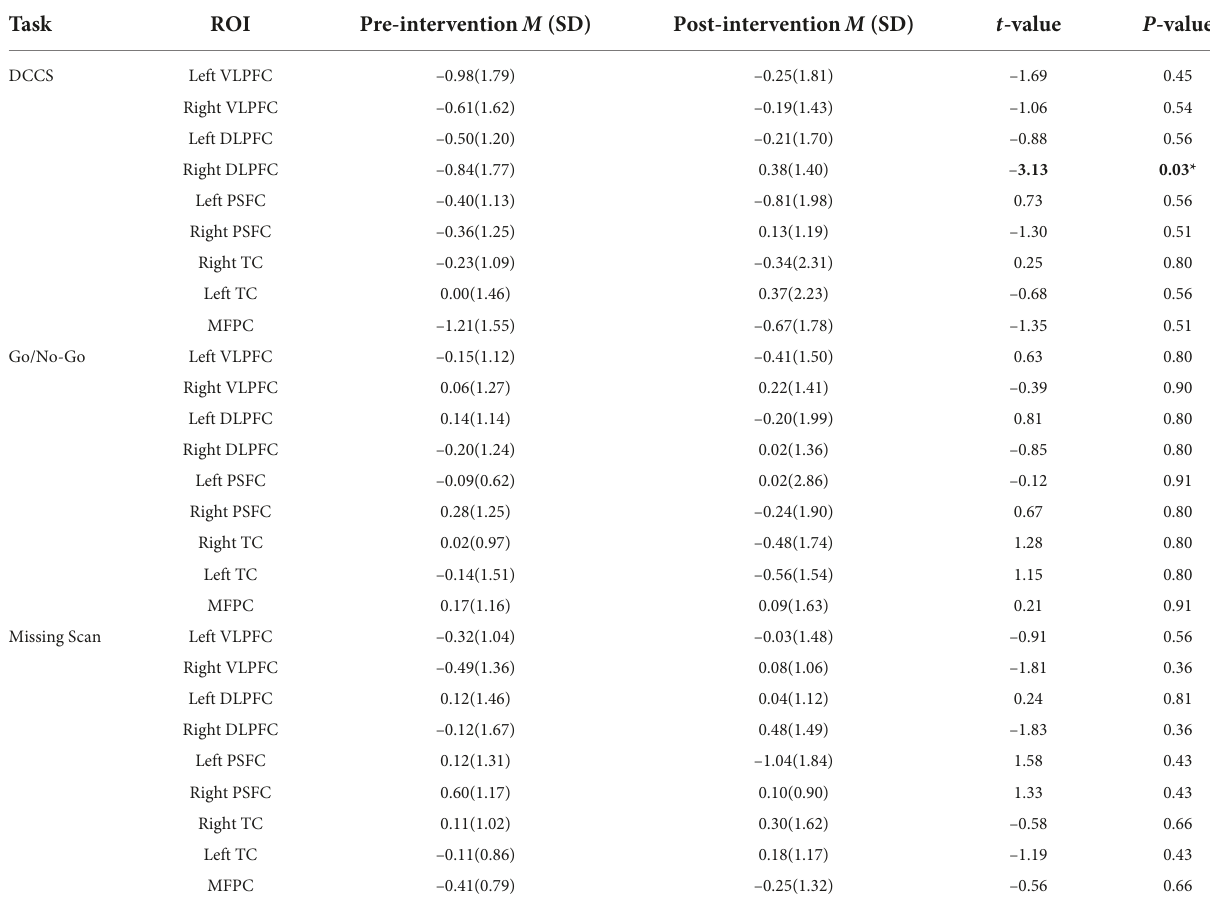
TABLE 2 Comparison of increases in HbO before and after the intervention (full